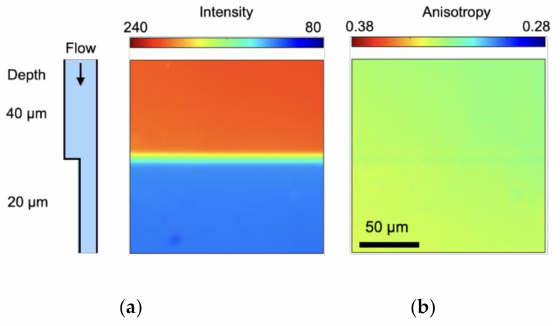
Figure 3. ( a ) Fluorescence intensity and ( b ) fluorescence anisotropy for fluorescein solution in a microchannel with different